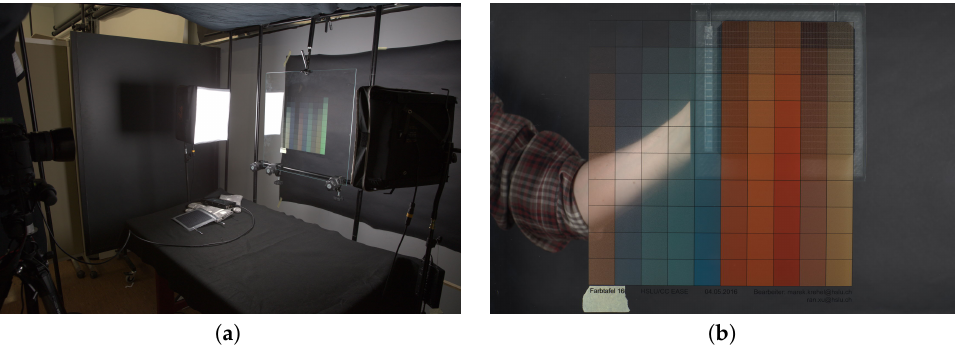
Figure 3. Image capture setup ( a ) for coloured glass samples. Uniform illumination is provided by two symmetrically placed LED studio lights. Each glass panel bearing 10 candidate colours in 10 print densities is mounted in a frame, allowing access to the back surface. The sample PV ( b ) is held against the glass panel’s back surface in each of the four quadrants for a quartet of